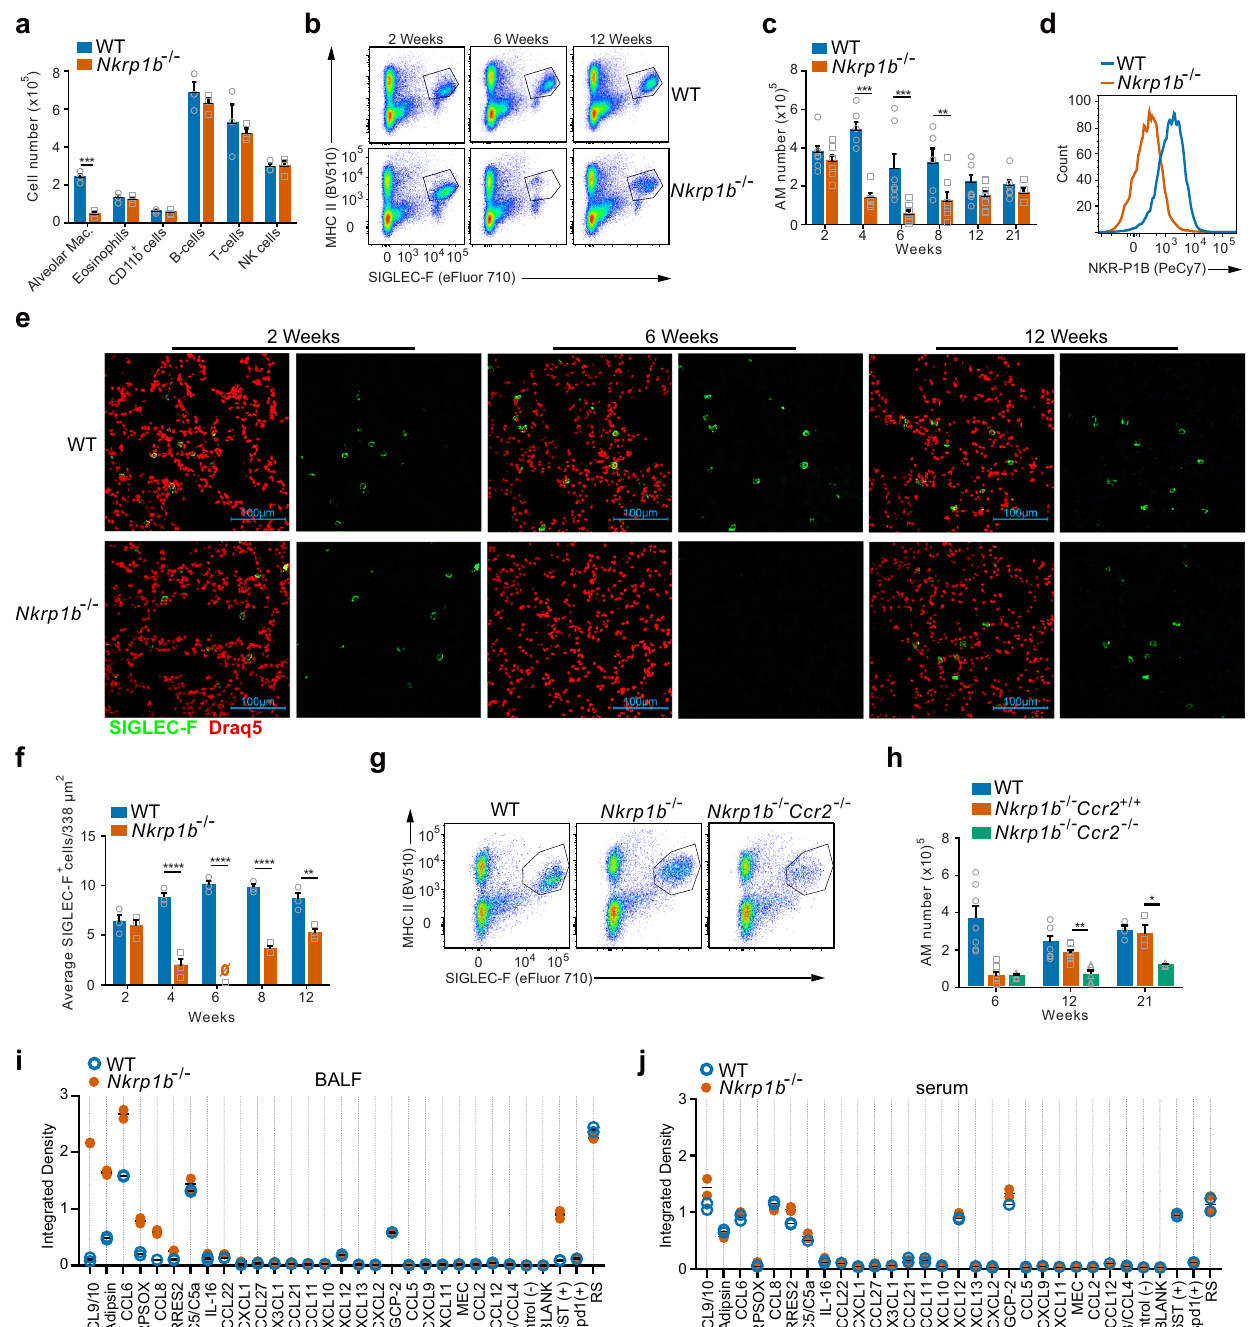
Fig.2|AMexpressNKR-P1BandNKR-P1B-de fi